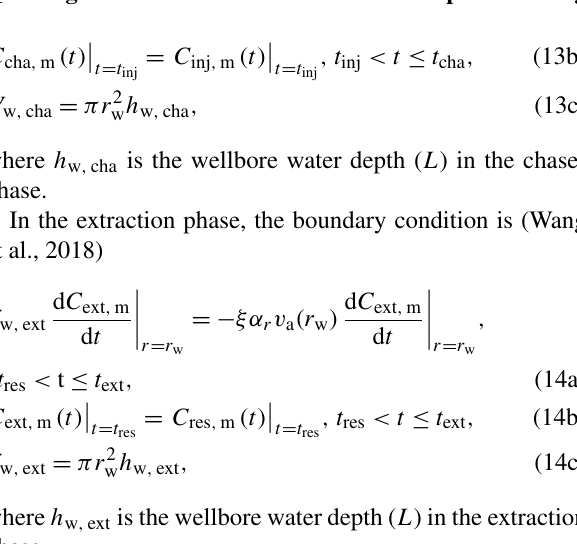
Figure 2. Comparison of BTCs at the well screen computed by the solution of this study and Chen et al.